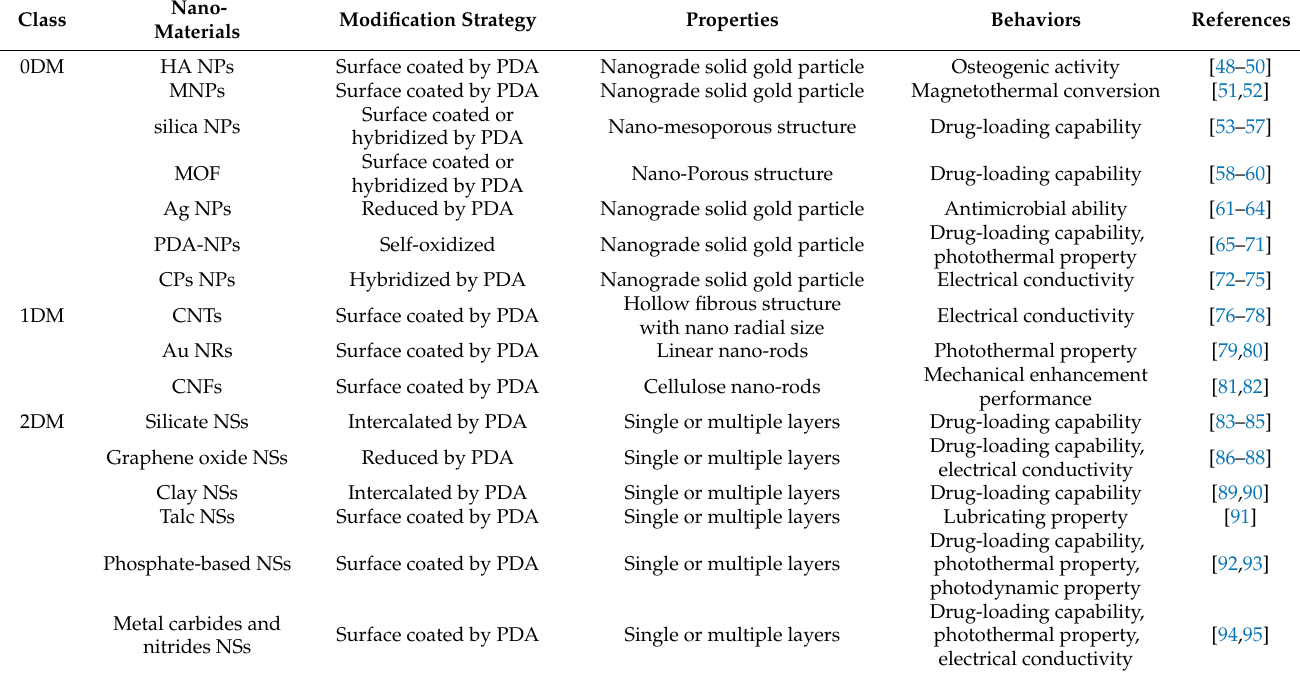
Table 1. Representative nanocomposite